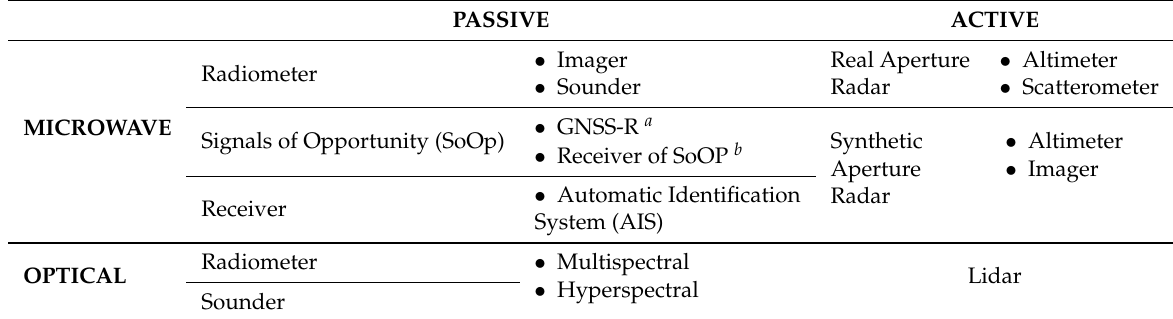
Table 4. Instrument categorization: potential instruments to complement the Copernicus system